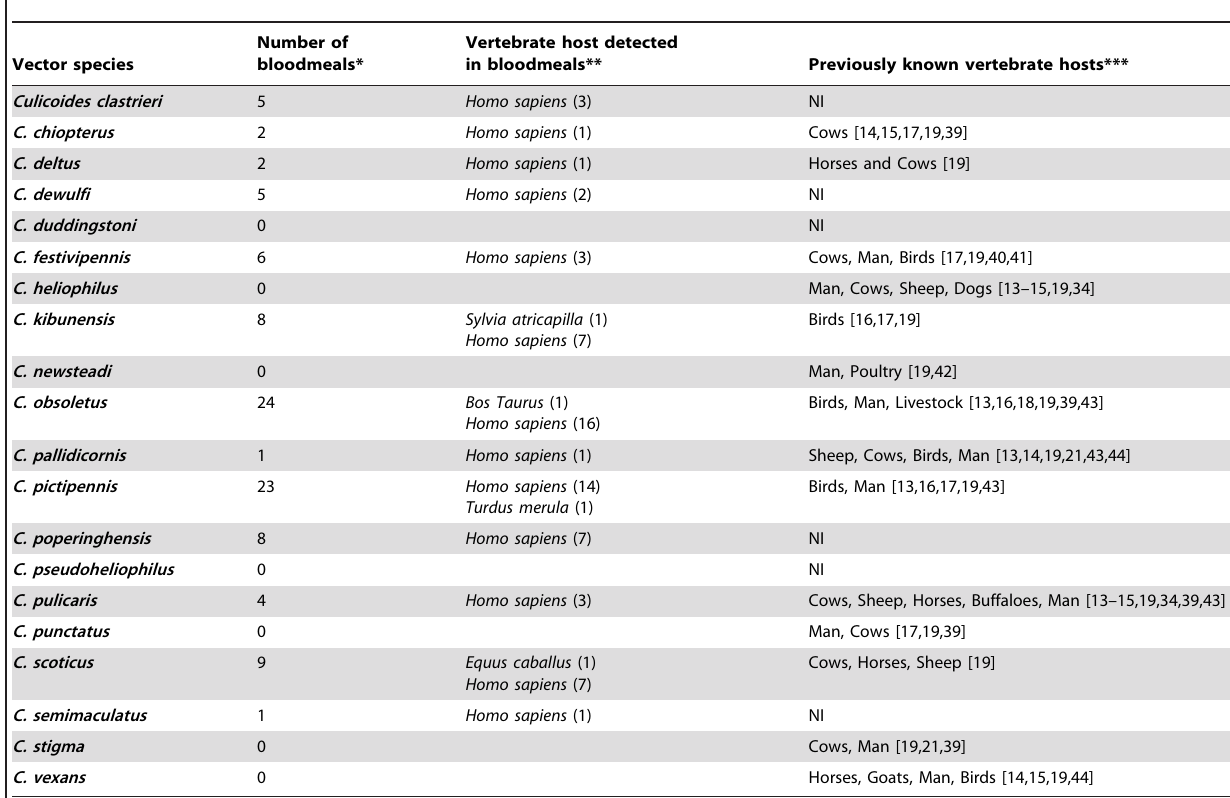
Table 1. Bloodmeals from Culicoides vector species found in the Mooswald forest of Freiburg, Germany.